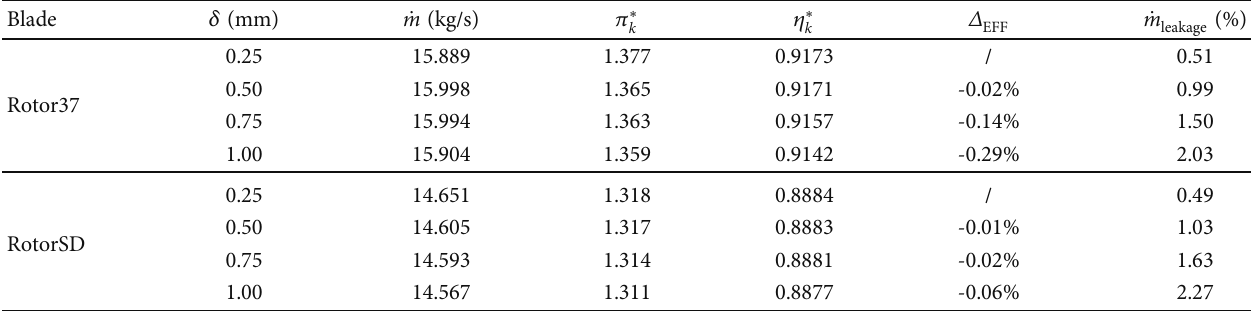
Figure 16: Contours of fl ow streamlines and entropy near the blade tip of RotorSD. Table 3: Performance of the two rotors at 70% design